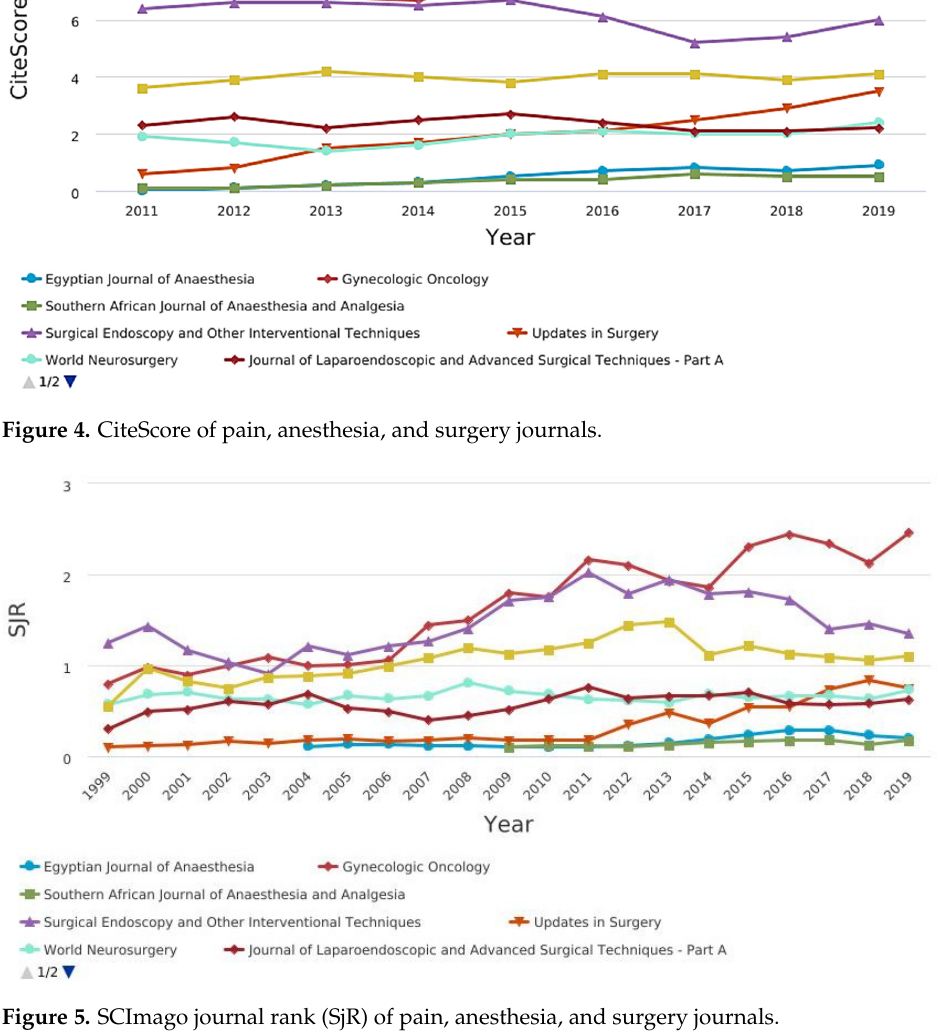
Figure 5. SCImago journal rank (SjR) of pain, anesthesia, and surgery journals.